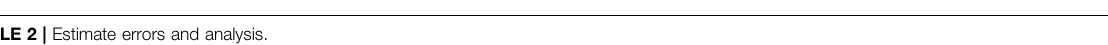
TABLE 2 | Estimate errors and